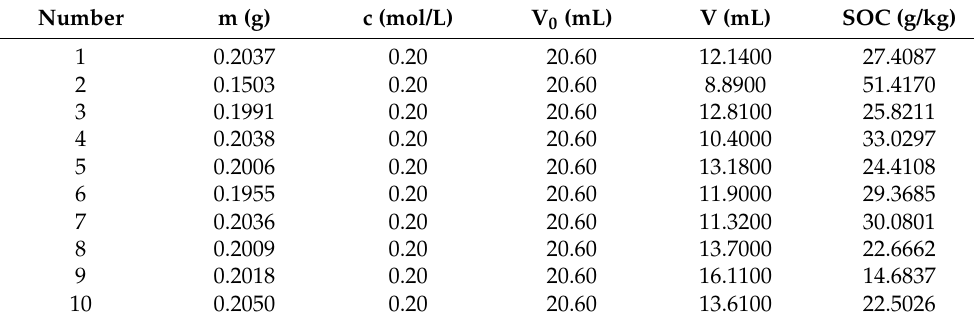
Table 2. Chemical analysis results of SOC content and other